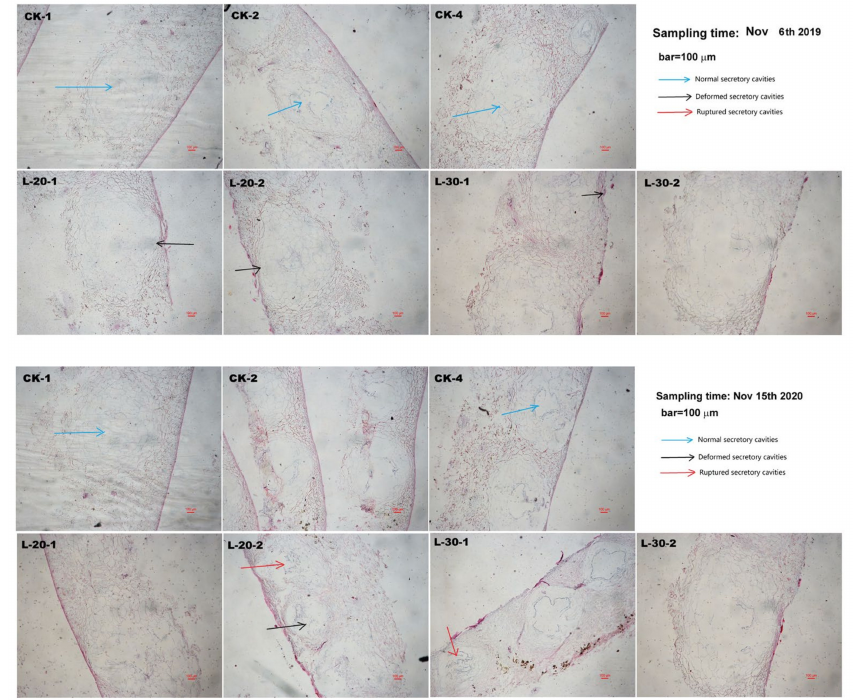
Figure 4. Observations of the cross-sectional anatomical structures of peel of fully-matured fruits (Sampling time: 6 November 2019 and 15 November 2020) under different fruit load treatments (bar = 100 µ